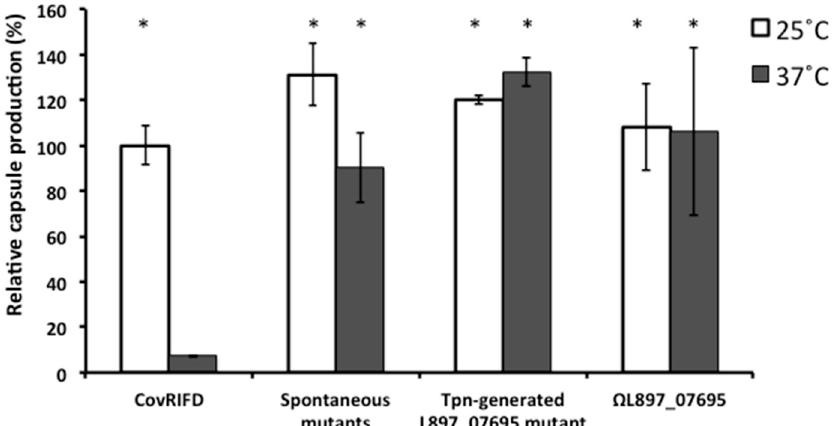
Figure 1. Quantitation of the capsule produced by Streptococcus pyogenes strains. The capsule produced by strains was quantitated and compared to that of the background strain CovRIFD incubated at 25 °C. Strains used: CovRIFD ( covR in ‐ frame deletion strain), the background strain showing capsule thermoregulation; spontaneous mutants, spontaneously ‐ generated capsule thermoregulation ‐ negative mutants; Tpn ‐ generated L897_07695 mutant, a mutant with a transposon insertion in the L897_07695 gene in CovRIFD; and Ω L897_07695, a strain with a targeted disruption of the L897_07695 gene in CovRIFD. The data are the means and standard deviations of at least three independent experiments. * indicates significance ( p < 0.01) for the difference between the amount of capsule production by strains at a given conditions and that by CovRIFD at 37 °C as calculated by the two ‐ tailed paired Student’s t ‐ test.